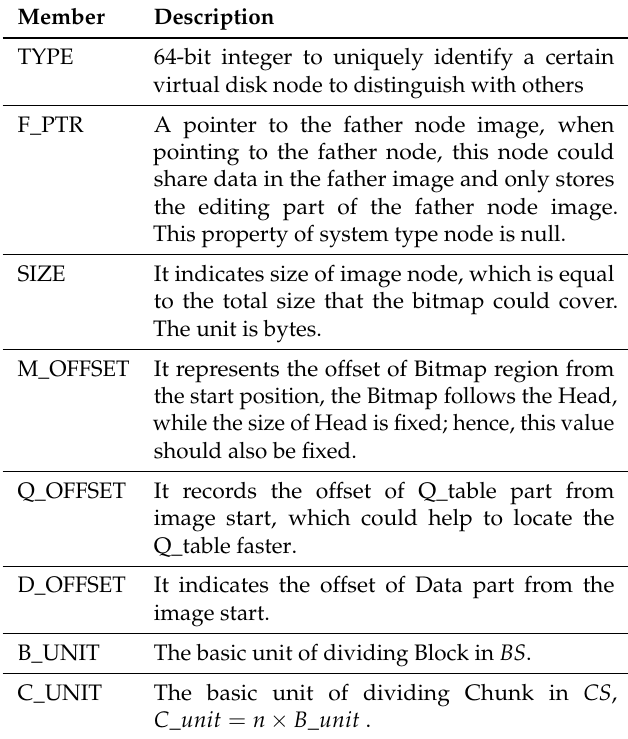
Table 2. The member variables of the